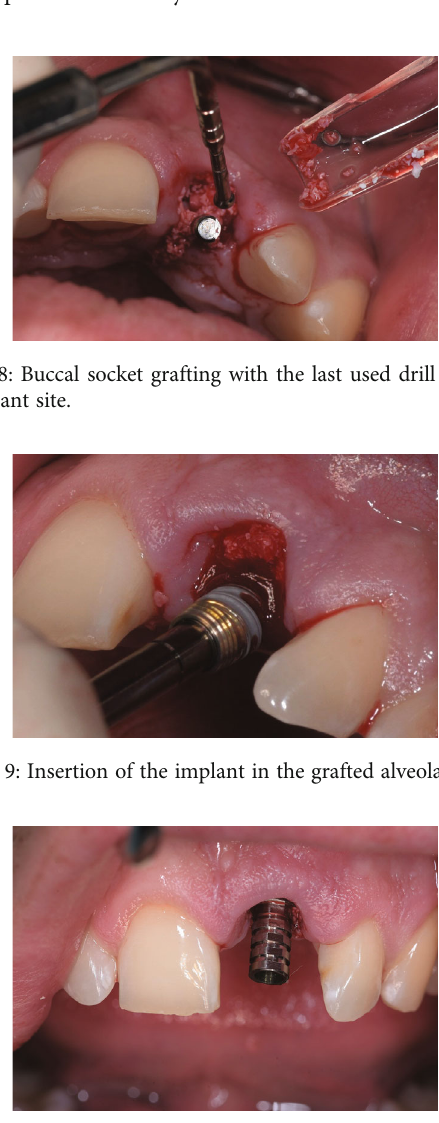
Figure 10: Temporary abutment snapped onto the